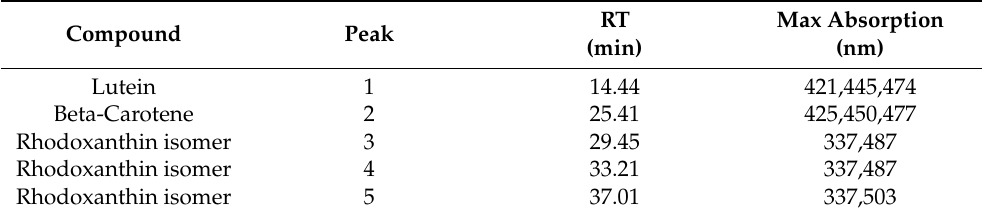
Figure 3. HPLC chromatogram of carotenoids in the total extract obtained by fresh arils of Taxus bac- cata ( A ) and fractions (fraction 1—( B ); fraction 2—( C ); and fraction 3—( D )). Five carotenoids are identified: (1) lutein, (2) β -carotene, (3), and (4) and (5) rhodoxanthin isomers. Table 2. HPLC peaks and corresponding compounds identified in red